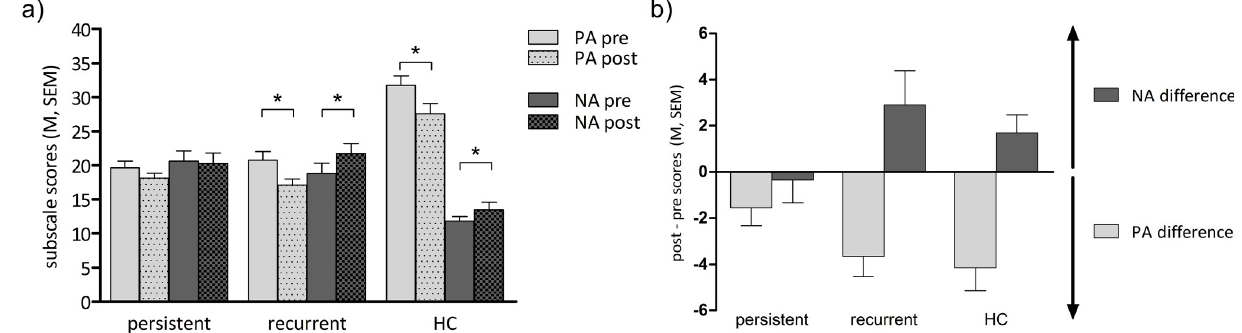
Fig 2. Affective reactivity. a) Group mean subscale scores with SEM for positive (PA) and negative affect (NA), pre and post mood induction, respectively. b) Difference scores (post-pre scores) for PA and NA per group. The greater the increase of NA as well as the decrease of PA, the higher the affective reactivity. persistent = patients with persistent depression, recurrent = patients with recurrent depression, HC = healthy comparisons. Asterisks indicate significant with-in group differences ( � p < .05, Bonferroni